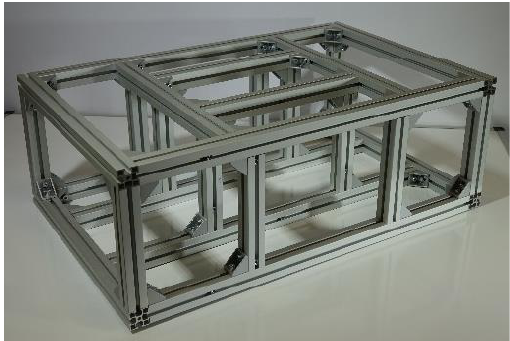
Figure 3. Assembled frame — photo.